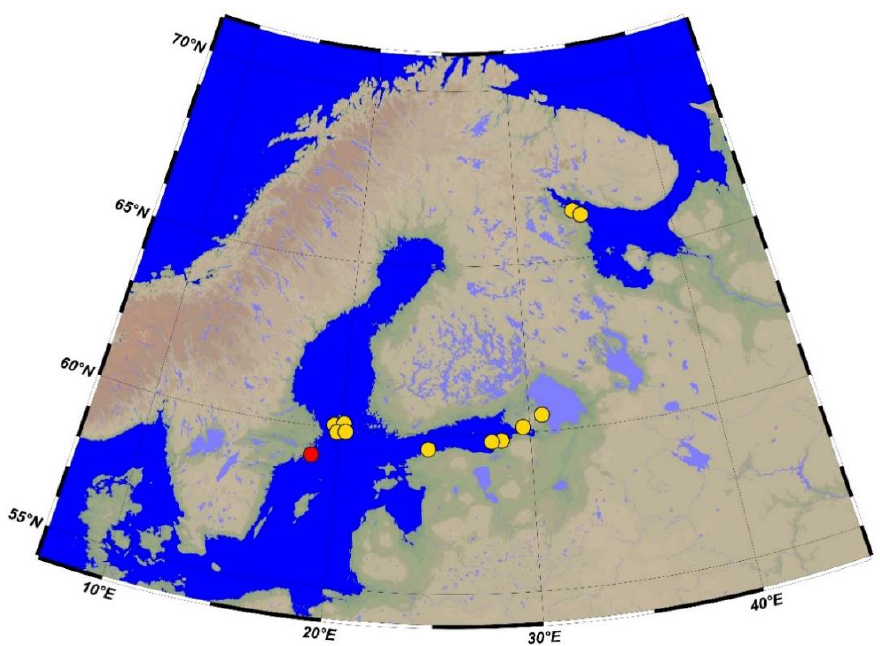
Figure 1. The map shows the localities of studied specimens of T. quadricornis in the Baltic Sea and Lake Ladoga and Triglopsis sp. in the White Sea. The red circle indicates the supposed type locality of T. quadricornis. The yellow circle marks the localities of non-type specimens of fourhorn sculpins.